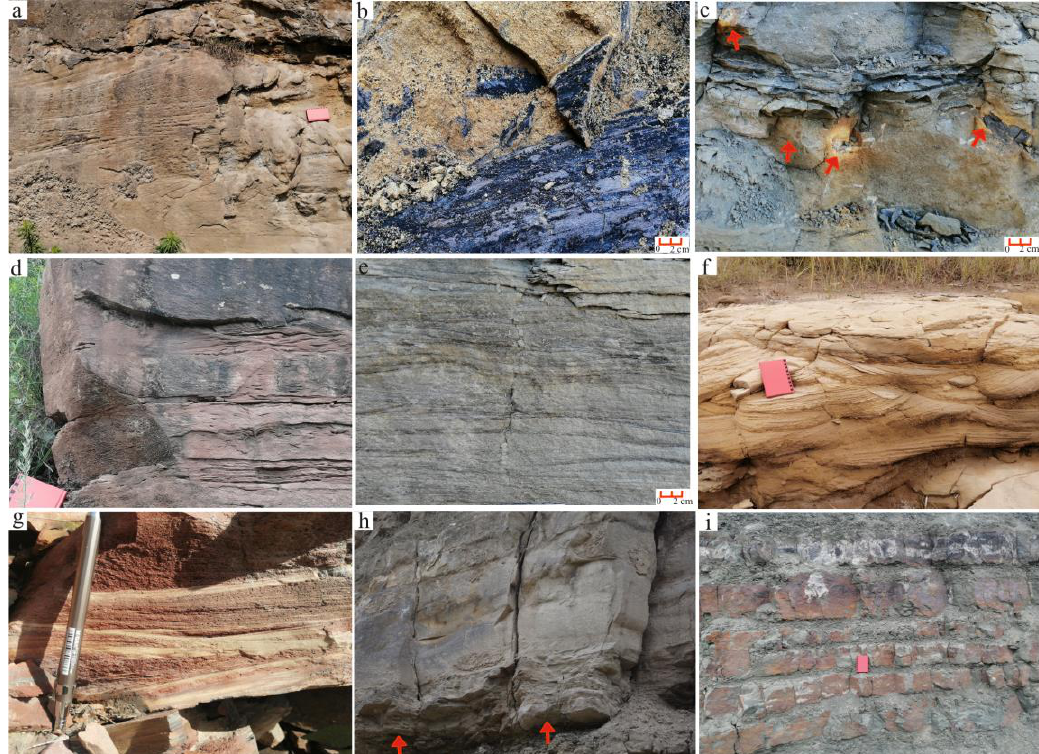
Figure 3. Sedimentary structures and lithologic characteristics of the Zhiluo Formation. ( a ) Trough and tabular crossbeddings, Zhiluotown section. ( b ) Plant remains and carbonaceous debris, Shenshangou section. ( c ) Pyrite nodule, Hengshan area. ( d ) Horizontal bedding, climbing-ripple cross-lamination, Zhiluotown section. ( e ) Small crossbedding and horizontal bedding, Zhongjitown area. ( f ) Small-scale crossbedding, Shenshangou section. ( g ) Brownish red fine sandstone and siltstone with small-scale crossbedding and horizontal bedding, Zhongjitown area. ( h ) Medium-coarse-grained braided channel sandstone, obvious channel scouring surface at the bottom of the sandstone, Zhiluotown section. ( i ) Delta front subfacies, Ansai section. The arrow in the images shows the position of the phenomena.